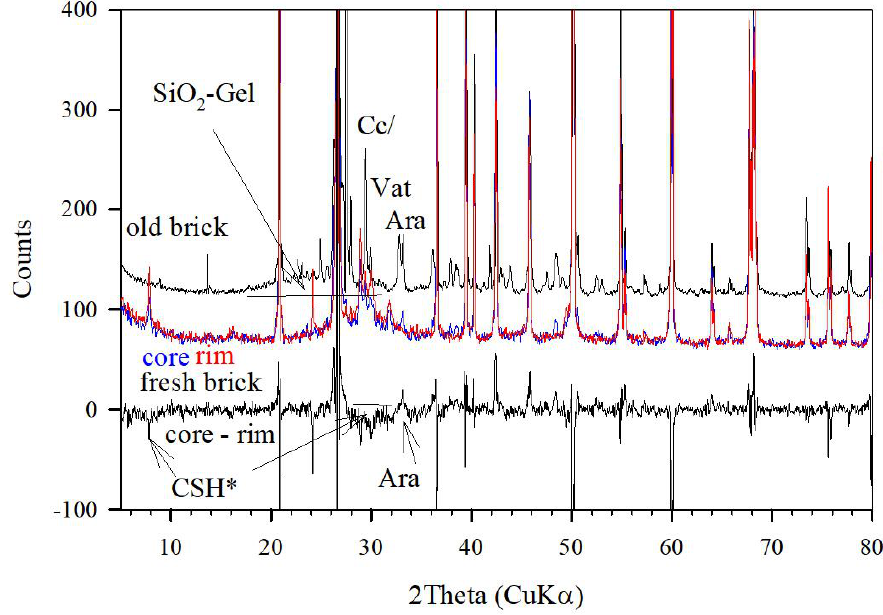
Figure 6. Along the ordinate enlarged XRD diagrams of a 20 year old lime-sand brick (old-brick) and a fresh lime sand brick (fresh brick), which is probed at the core and rim (plotted in blue and red onto each other. The lower graph shows the difference pattern (core-rim). Ara = Aragonite, Vat = Vaterite, Cc = Calcite. -CSH* = peaks showing the destruction of the crystalline CSH-phase in the difference pattern.